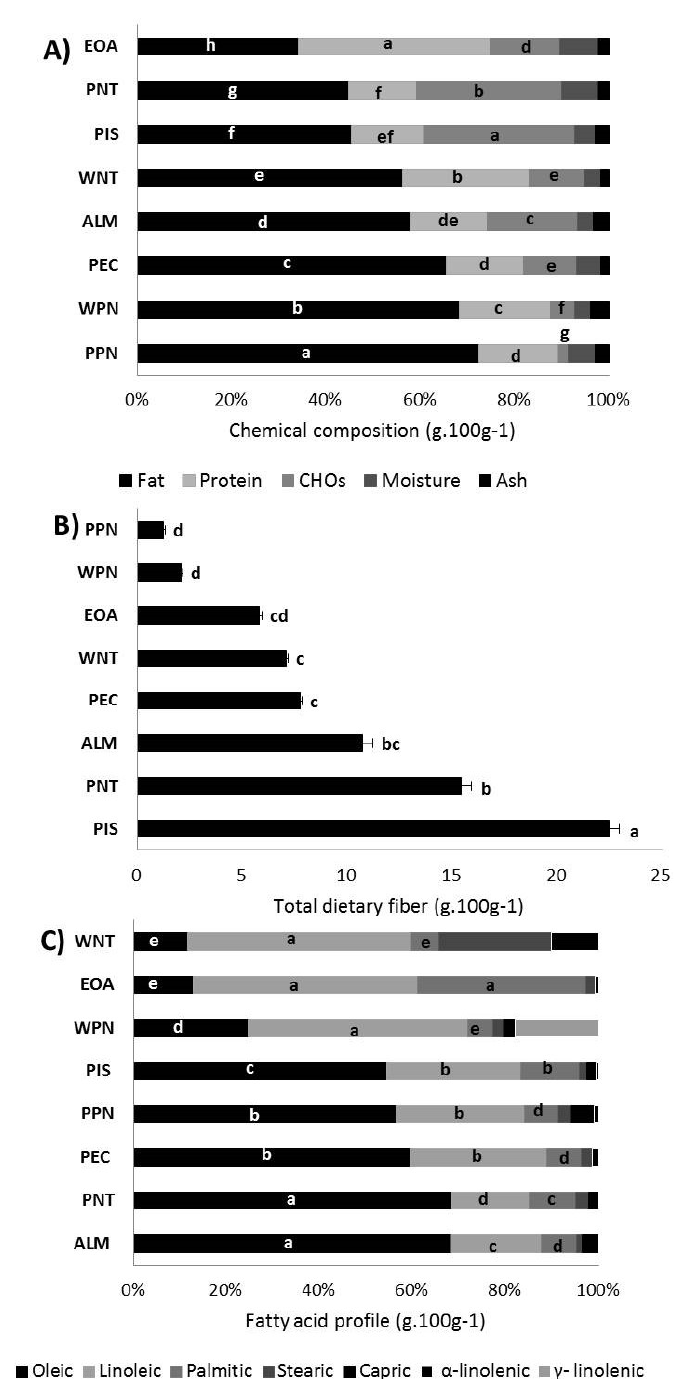
Figure 2. Chemical composition of edible nuts. Chemical (proximate) composition ( A ), total dietary fiber ( B ), fatty acid profile ( C ). Different letters within the same bar color series (per figure) indicate significant differences ( p < 0.05). Almond (ALM), Emory oak acorn (EOA), pecan nut (PEC), pistachio (PIS), peanut (PNT), pink pine nut (PPT), walnut (WNT), and white pine nut (WPM).